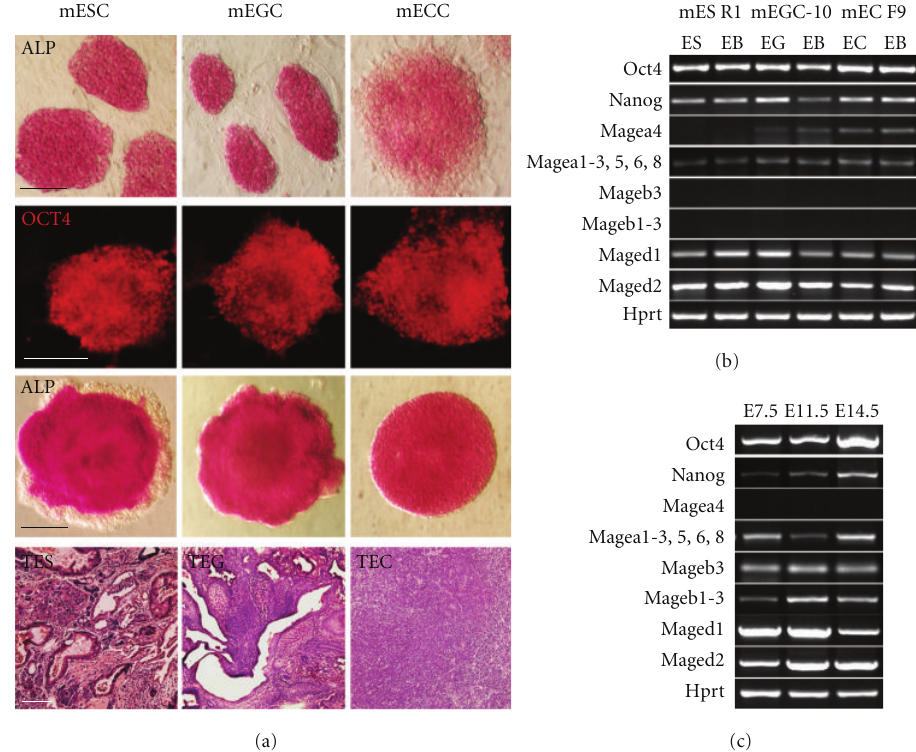
Figure 5: Gene expression profiles of CTAs in mouse ES, EG, and EC cells and in mouse germ line cells. (a) Pluripotent ES and EG cells and nullipotent EC cells express alkaline phosphatase and Oct4 and develop EBs; ES and EG cells di ff erentiate into derivatives of three germ layers in teratomas (TES, TEG) while EC cells grow in vivo as malignant tumors (TEC). Scale bar equal 100 μ m. (b) Expression of CTAs, Oct4, and Nanog in mouse ES, EG, and EC cells and EBs. (c) CTA expression profiles of germ line cells isolated from embryos of E 7.5, E 11.5 and E 14.5